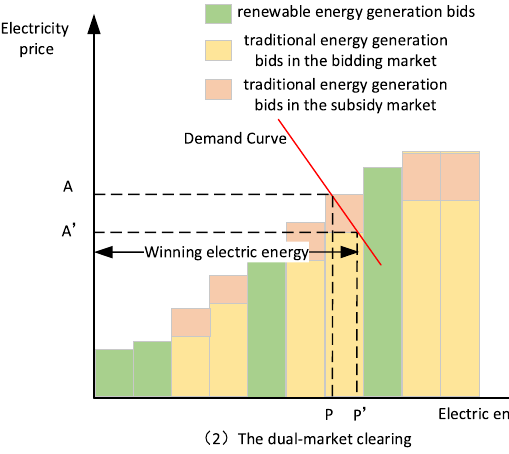
Fig. 1 Current market clearing in the spot market mechanism Fig. 2 Market clearing in the dual-market clearing